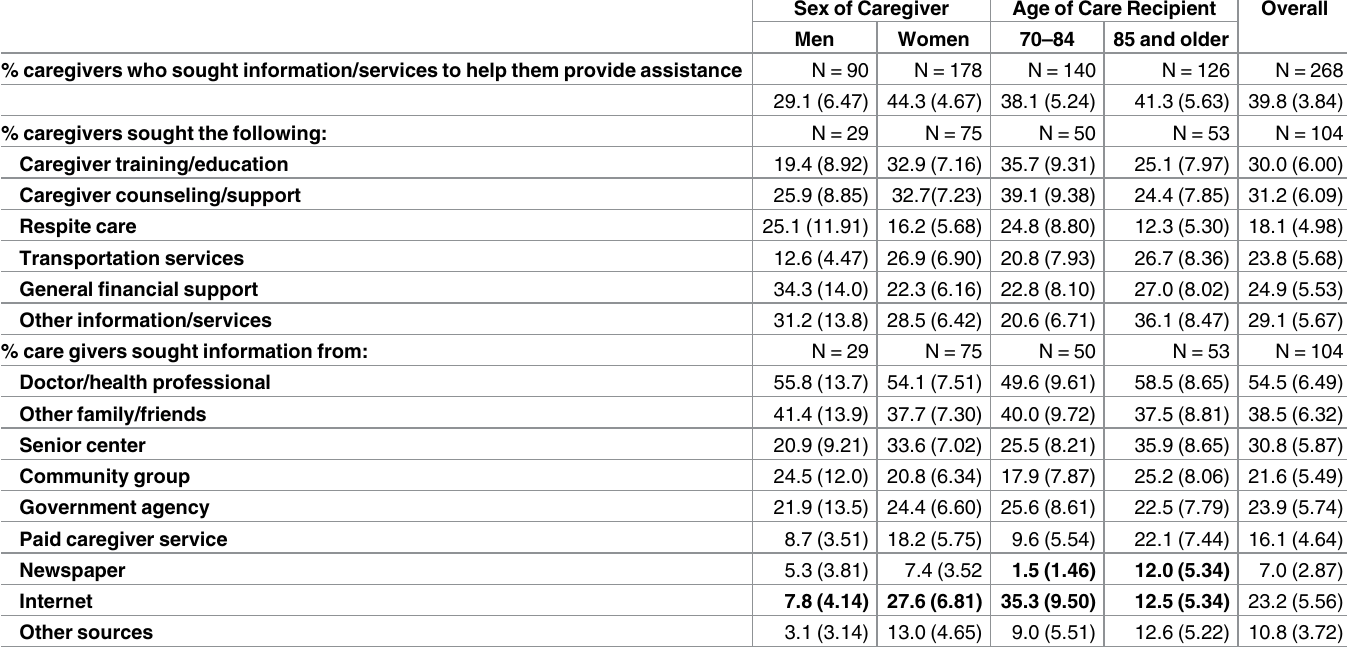
Table 6. Transportation caregiverinformation seeking by sex, age of care recipient, and overall (standard error of the percent).